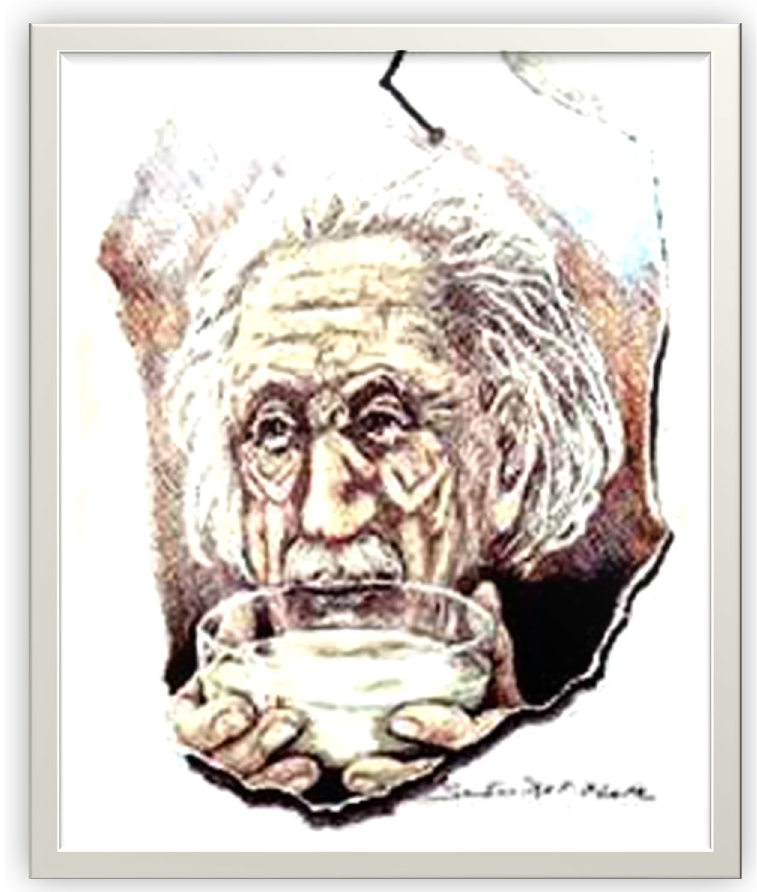
Figure 6. Faces/people and container of liquid (bowl of water).